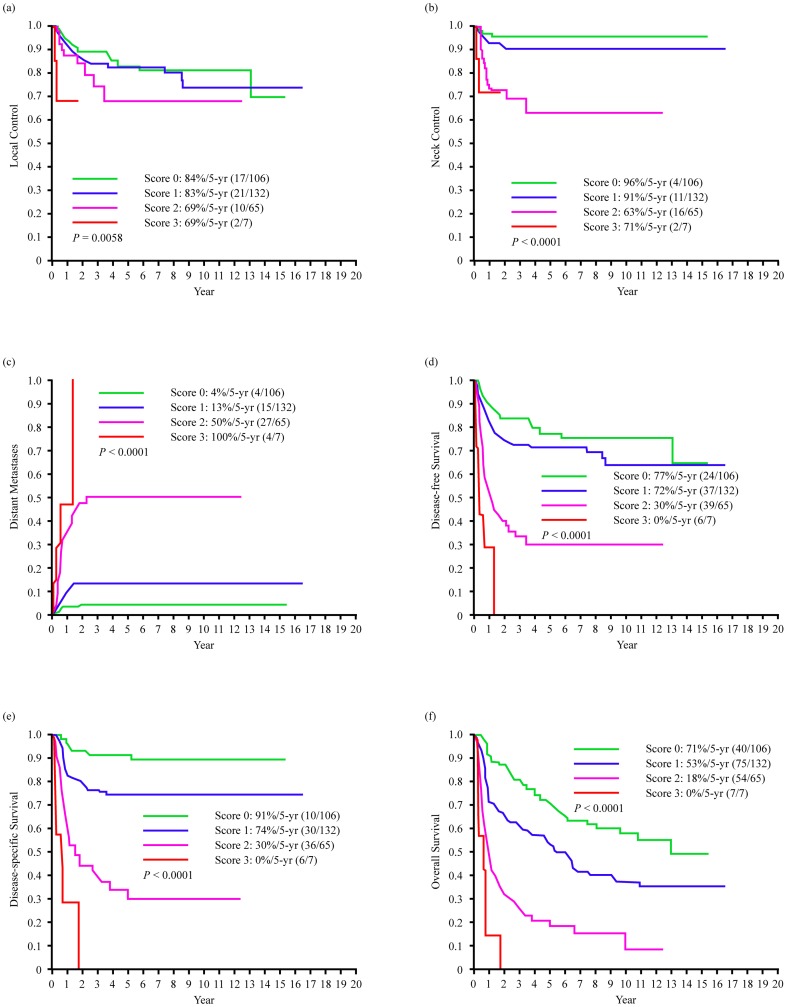
Kaplan-Meier estimates of 5-year outcome in the segmental mandibulectomy patients stratified by level IV/V metastases, extracapsular spread status and tumor depth of ≥15 mm, (a) local control, (b) neck control, (c) distant metastases, (d) disease-free survival, (e) disease-specific survival, (f) overall survival.